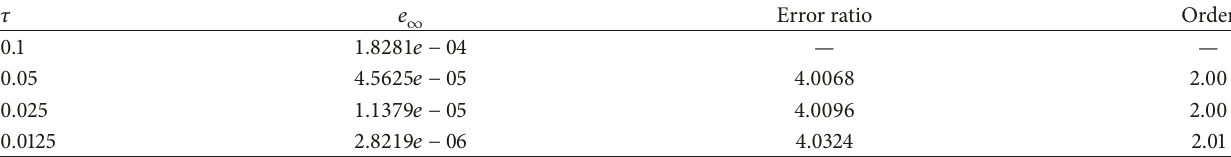
Table 2: The error, error ratio, and accuracy order computed by the CM-IIF2 scheme with ℎ = 0.1 at time 푡 = 1 (Example 1).